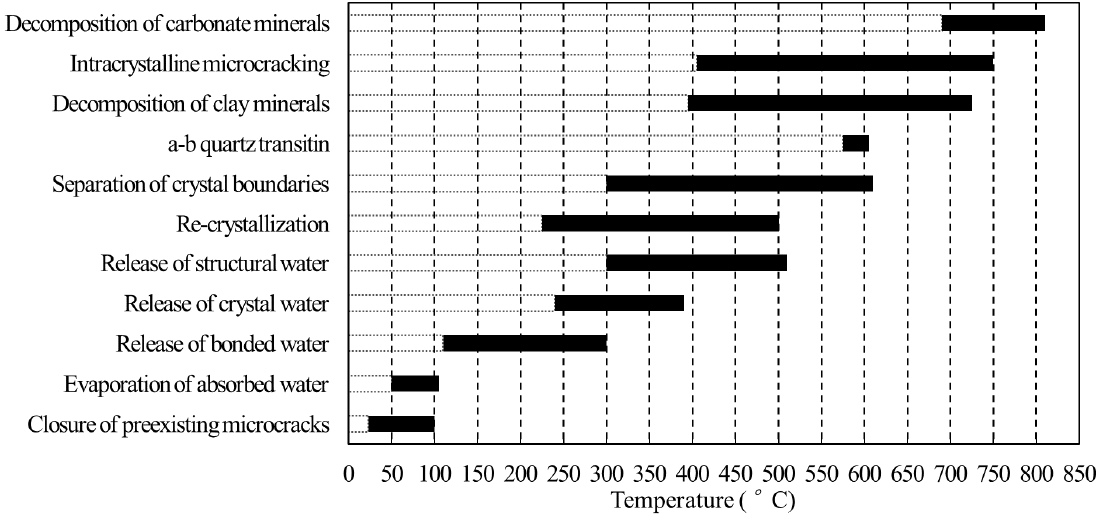
Figure 3. Major changes in rock at elevated temperatures [32].